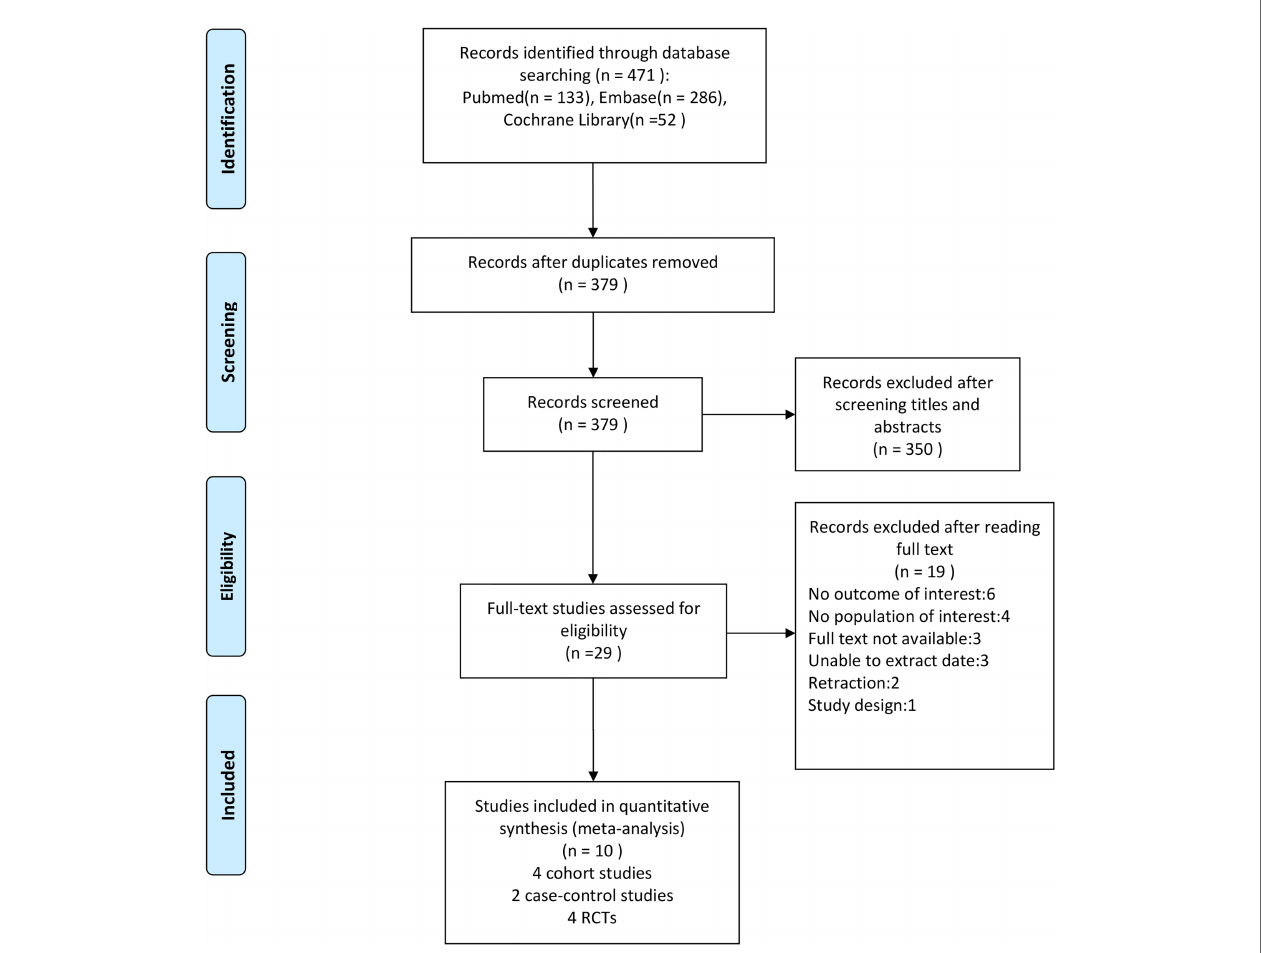
FIGURE 1 | Flow diagram of the literature search process and study